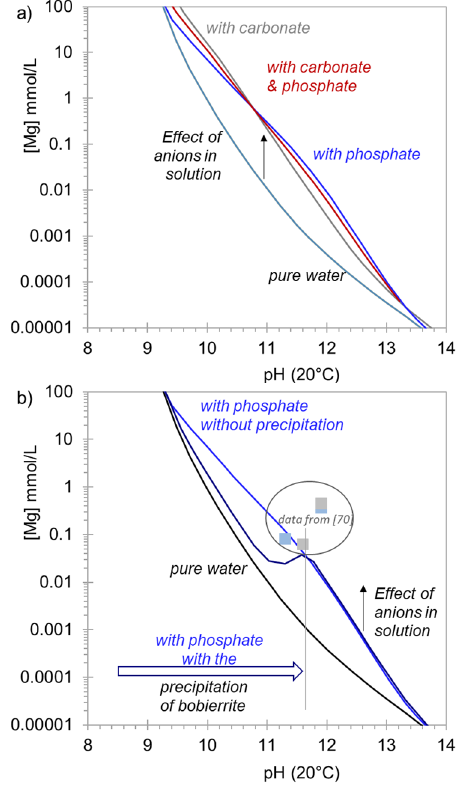
Figure A1. a) Brucite solubility curves in pure water and in carbonated solution (CO 32 ‐ = 80 mmol/L) and with phosphate (3 wt.% of NaHMP) (Mg ‐ phosphate phase precipitations excluded) b) comparison with data in literature ([70] after 1 and 10 days of reaction, phosphate (0.5 and 2